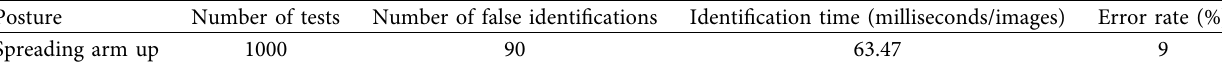
Table 3: Results of object